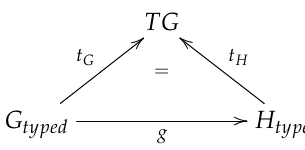
Figure 7. Typed graph morphism.